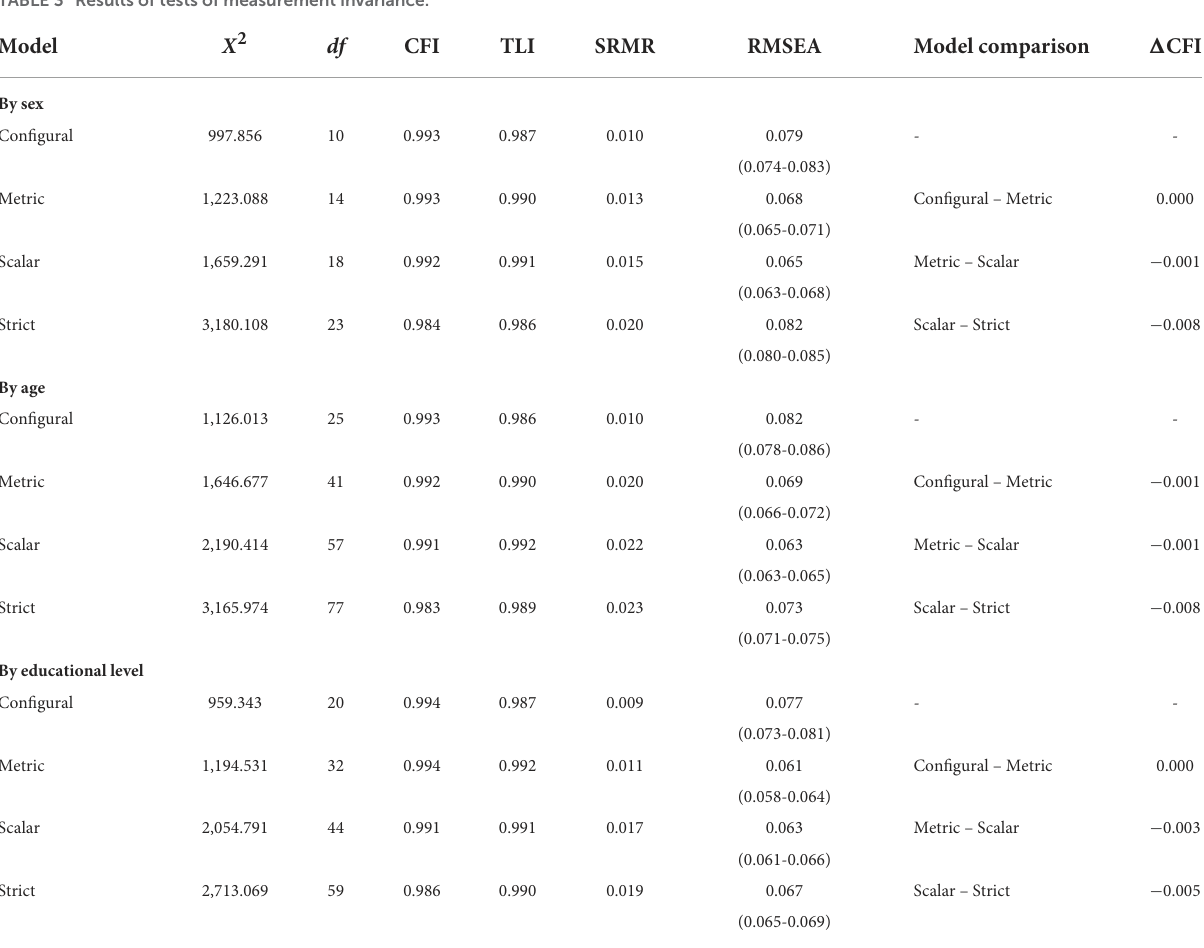
TABLE 3 Results of tests of measurement